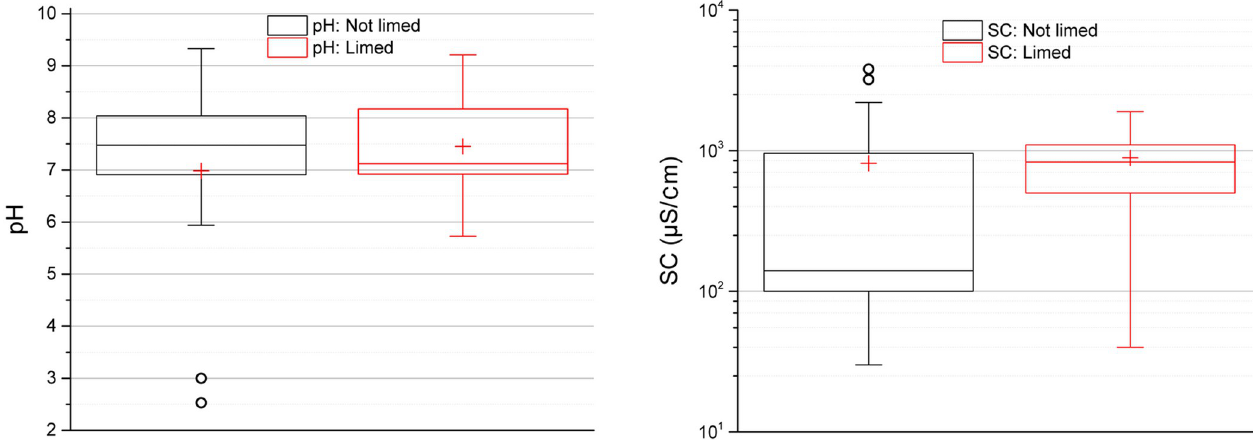
Fig 1. Water quality parameters pH and specific conductivity (SC) in surface water. Limed pit lakes (n = 13) in red, and non-limed pit lakes (n = 14) in black. The height of the box shows the interquartile range, which contains 50% of the values, the horizontal line inside the box shows the median value and the red cross denotes the mean value. The whiskers are lines that extend from the box to the highest and lowest values excluding outliers (o). Outliers represent those data with values being 1.5 higher or lower than the height of the box. Detailed data are given in supplementary data file.